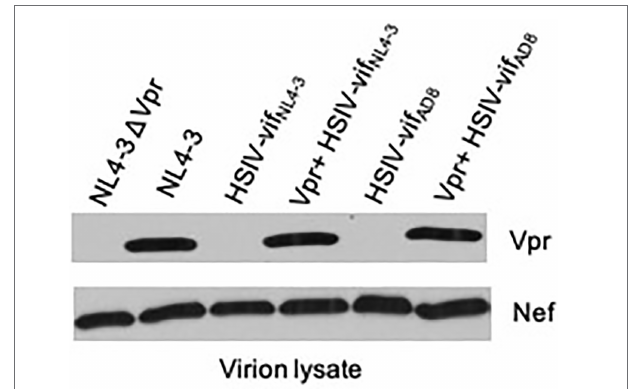
FIGURE 3 | Vpr expression from HSIV clones. 293 T cells were transfected with HSIV clones. At 48 h post-transfection, virus supernatants were collected and concentrated by centrifugation. Virion lysates were analyzed by western blot using antibody to HIV-1 Vpr and